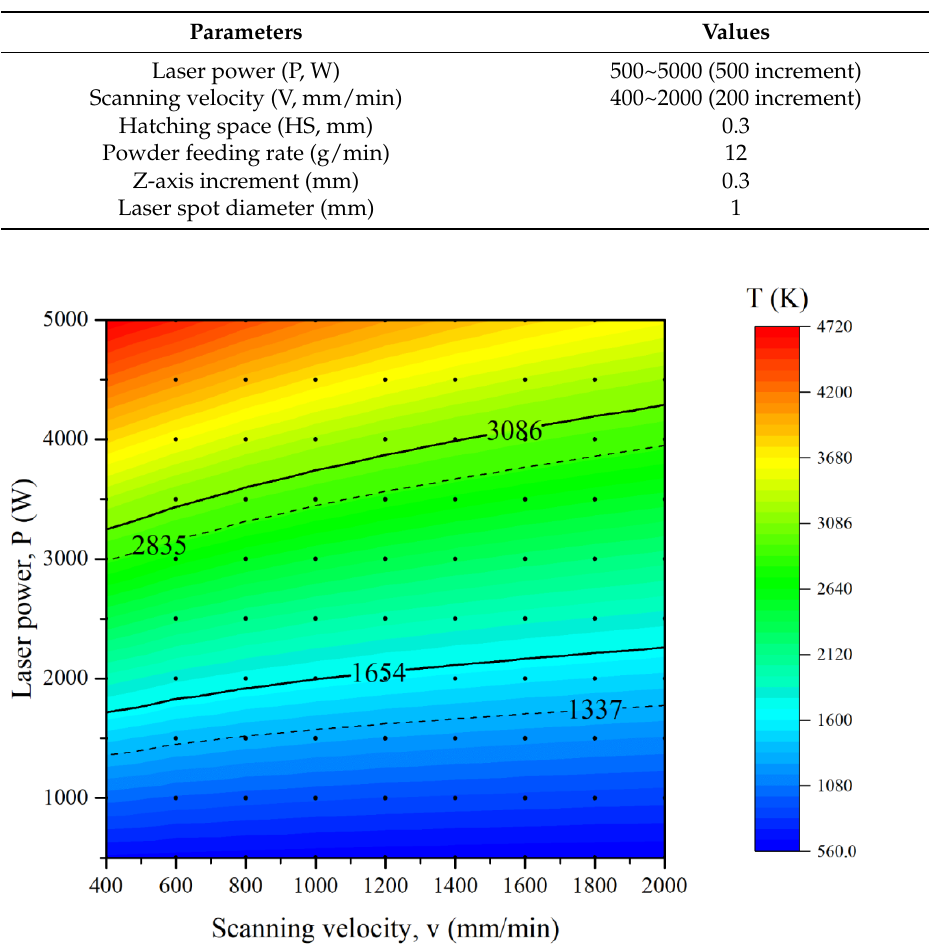
Figure 7. The peak temperature of different parameters for the first layer (T s_cu = 1337 K, T s_steel = 1654 K, T b_cu = 2835 K, T b_steel = 3086